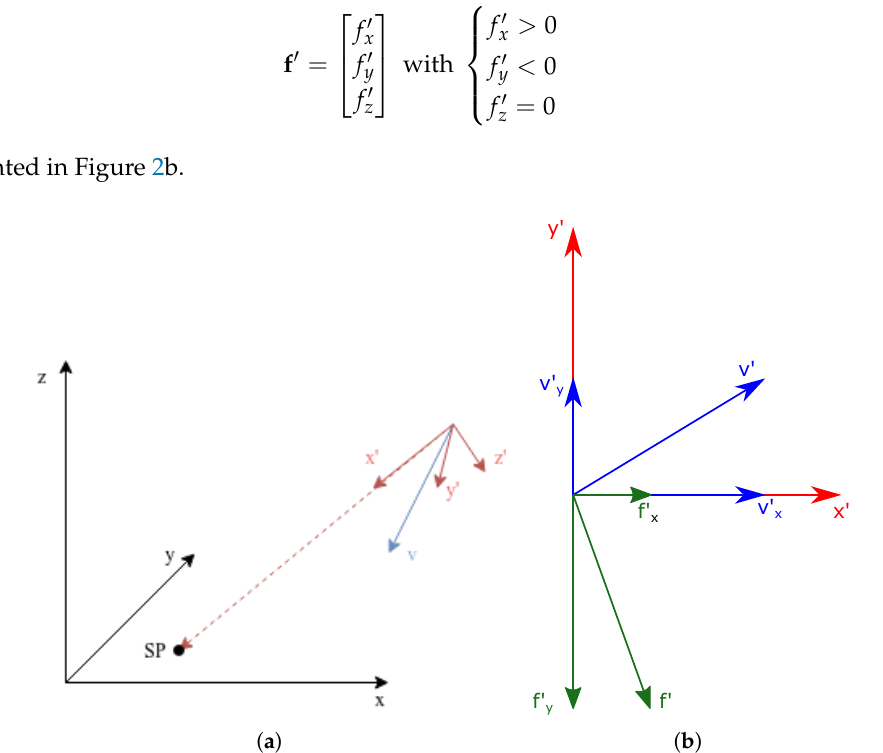
Figure 2. 3d view of the velocity components ( a ) in the mobile reference frame and forces needed to change the velocity direction in the x (cid:48) − y (cid:48) plane ( b